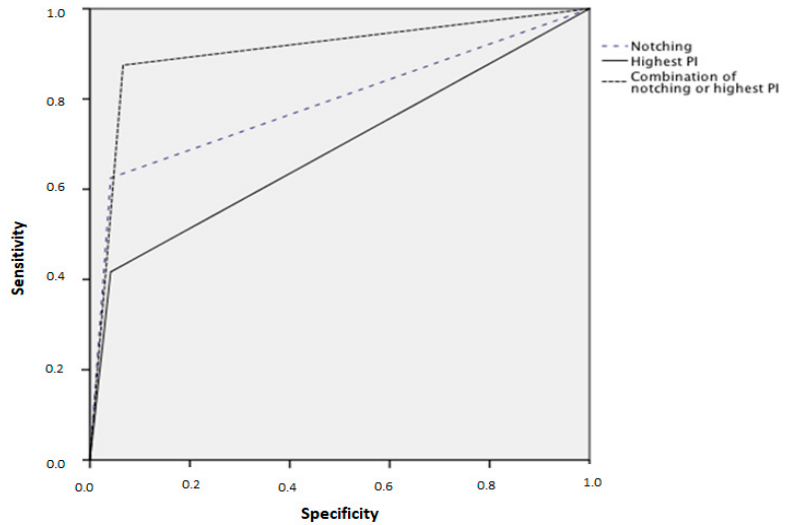
Figure 1. Screening receiver operating characteristics curves for prediction of preeclampsia.